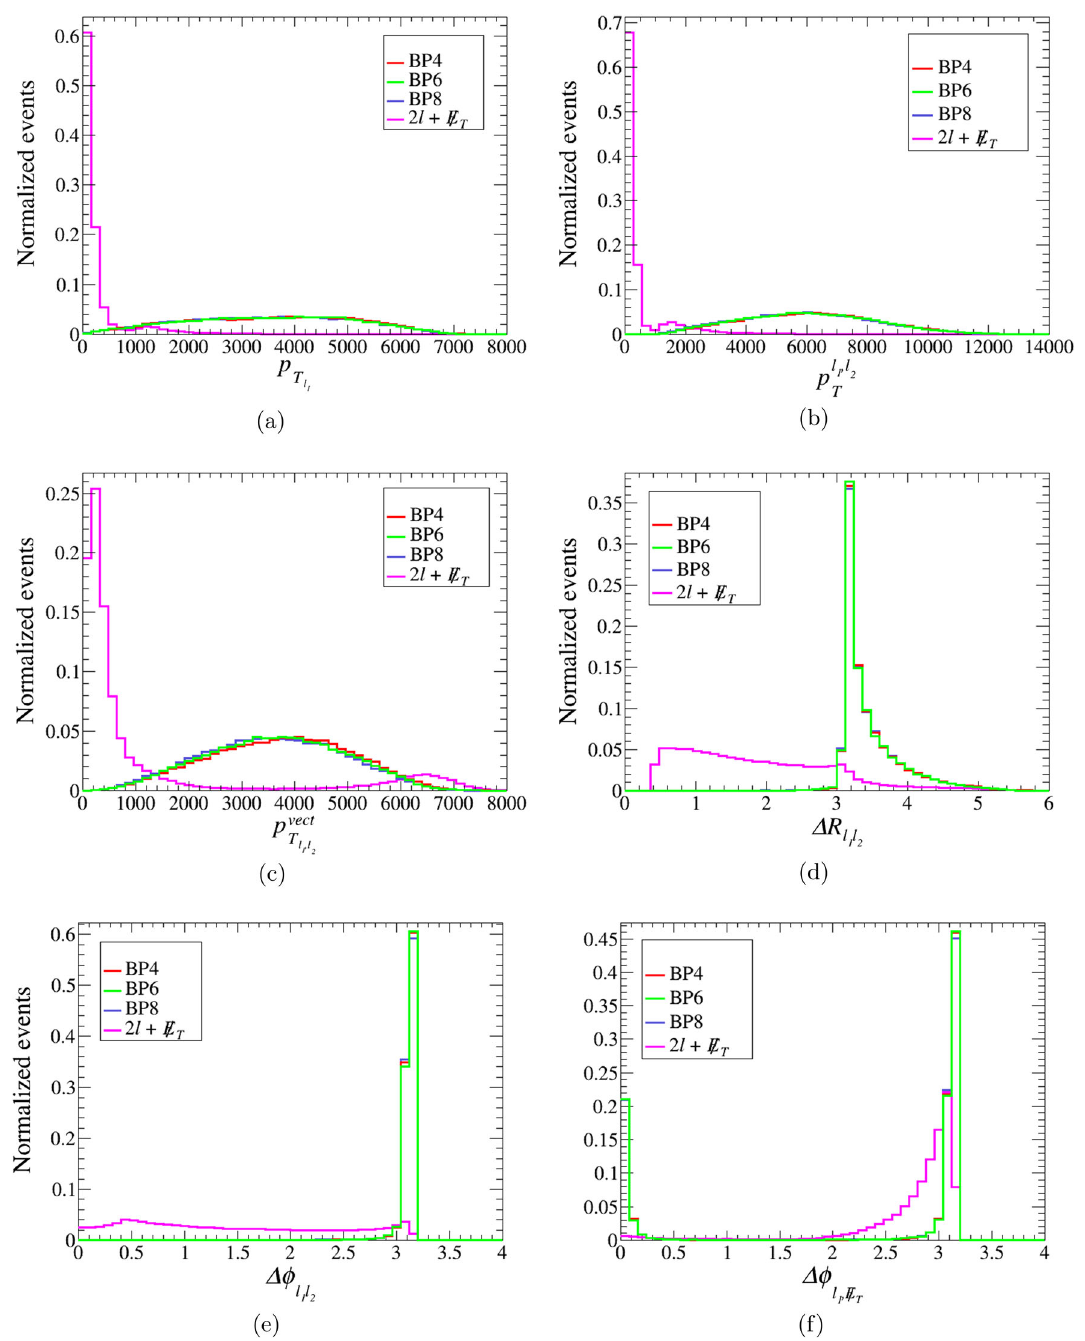
Fig. 6 Normalized distributions of the kinematic variables a p T for 2 l + E T / channel at 14 TeV muon collider the distributions for individual transverse momentum of the final state leptons as expected. Since the signal distri- butions for almost all benchmarks start overshadowing the SM background distribution for M ef f > 2 TeV, to achieve large significance, we apply a 2 TeV lower cut on M ef f